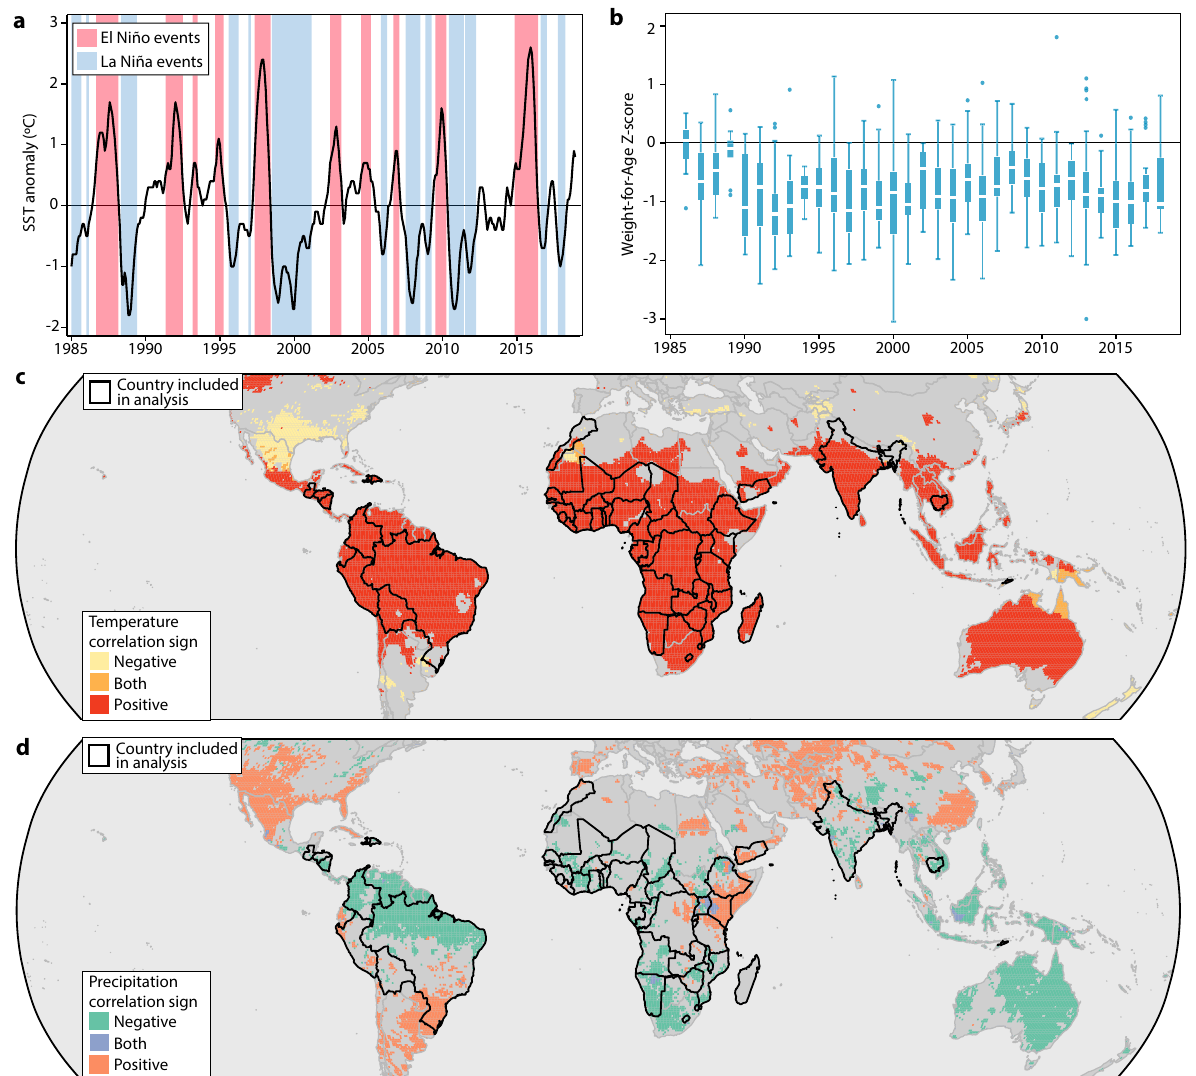
Fig. 1 De fi ning the sample of teleconnected children. a ENSO time series. El Niño or La Niña highlighted in red or blue, respectively. El Niño and La Niña states are de fi ned as follows: when the maximum of a 3-month rolling mean of monthly Oceanic Niño Index (ONI) values is >0.5°C (Niño-like) or < − 0.5 °C (Niña-like) compared to a moving reference climatology following NOAA CPC guidelines 38 . b Weight-for-age z -score distribution over time in teleconnected countries ( n = 1,253,176 children from 51 surveys). Box plots indicate median (middle white line), 25th, 75th percentile (box), and 5th and 95th percentile (whiskers) as well as outliers (single points). Country composition within each year is different, as a rotating sample of countries is surveyed in each year under the DHS program. c Pixel-level monthly correlation of surface temperature (1980 – 2010) from the UDEL climate dataset and 2-month lag of NINO3.4 Sea Surface Temperature (SST) in teleconnected locations. Teleconnections are de fi ned as pixels where the local temperature shows ≥ 3 statistically signi fi cant months of correlation with the second month lag of NINO3.4 SSTs. Country boundaries indicate sample countries (those having at least 50% of the population living in locations where local temperature is signi fi cantly correlated with the second month lag ( t – 2) of the NINO3.4 SST index for at least 3 months of the year and with at least two Demographic and Health Surveys measuring anthropometrics). d Pixel-level monthly correlation of precipitation (1980 – 2010) and 2-month lag NINO3.4 SST. There is substantial heterogeneity in how precipitation is affected by ENSO, with areas of both positive and negative correlation. Country boundaries again show sample outcomes re fl ecting recent nutrition, including weight-for-height and body mass index (BMI; − 0.04 σ /°C and p < 0.01 for both measures). Using WHO z -score classi fi cation thresholds, warmer ENSO increases the prevalence of underweight (below − 2 σ in weight-for-age) signi fi cantly by 0.6 percentage points per 1 °C ( p < 0.05). We fi nd that the risk of wasting (below − 2 σ in weight- for-height) is similarly positive but not signi fi cant (0.3 p.p./°C,